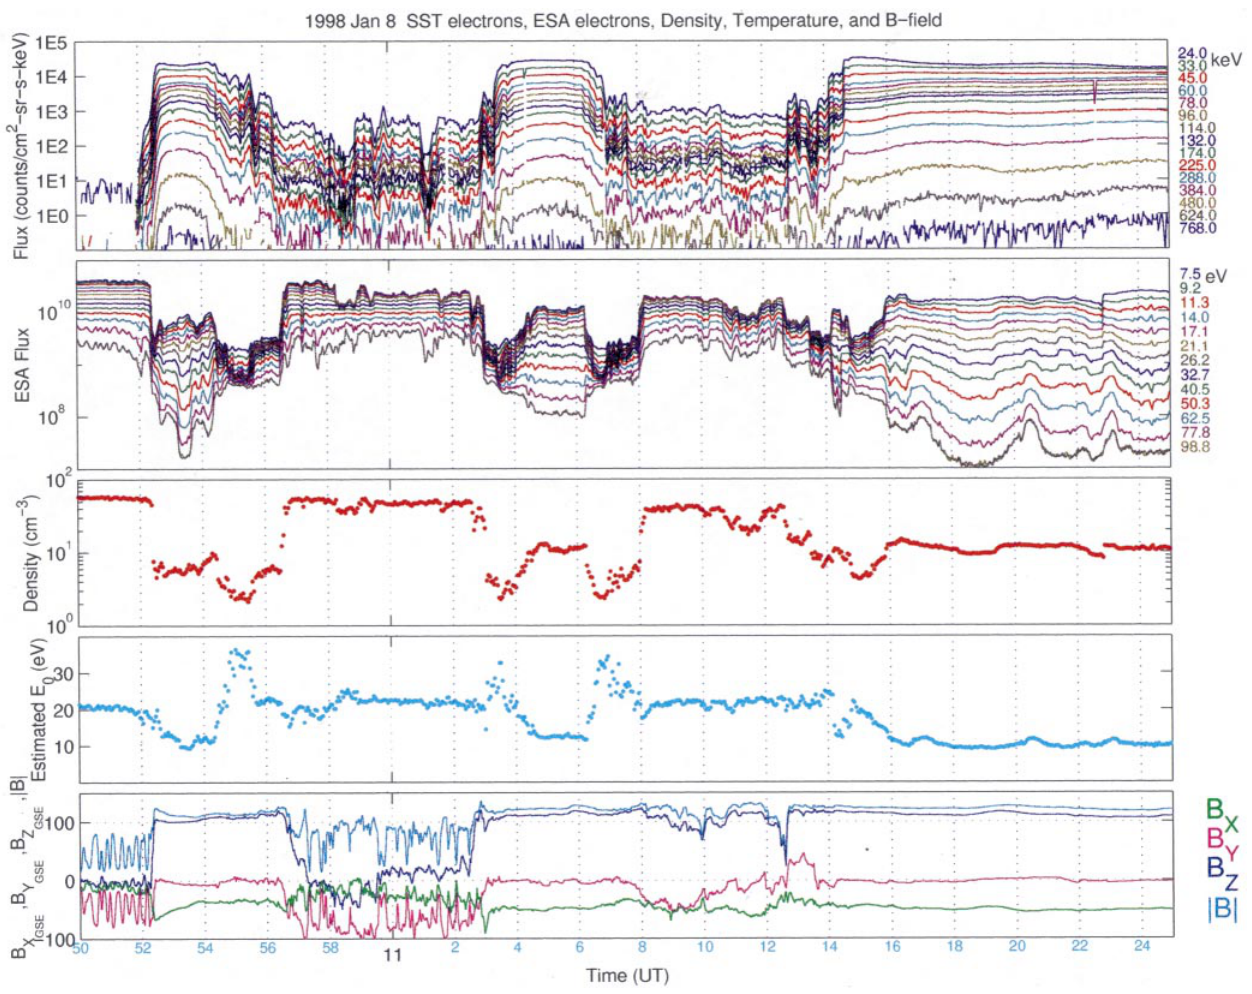
Fig. 3. A high time resolution (3 s) plot emphasizing the features of the boundaries. Electron density and e-folding energies are included in addition to the